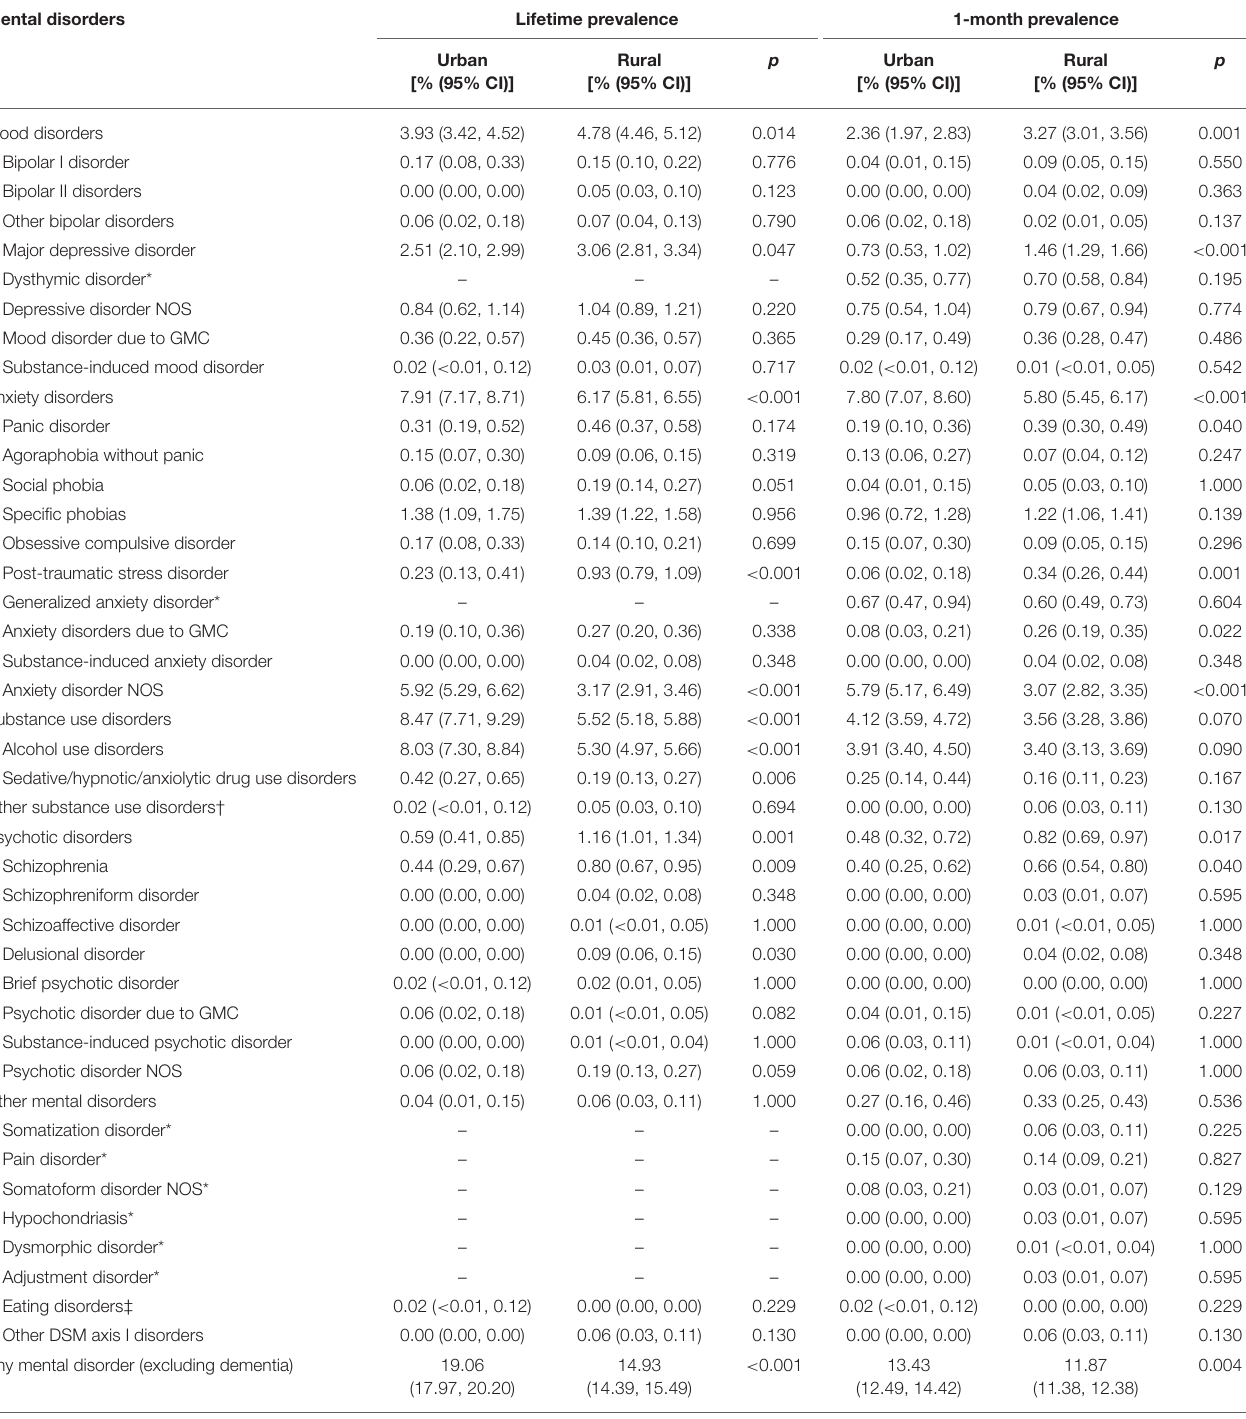
TABLE 6 | Weighted lifetime and 1-month prevalence of mental disorders by region in Hebei province, China ( n =